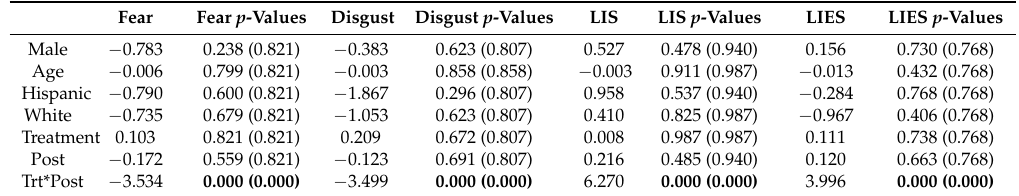
Table 3. Log Odds Ratio Estimates for Cumulative Logit Models Separately Fit for Fear toward Spiders, Disgust toward Spiders, Likelihood of Incorporating Information about Spiders into their Science Classroom (LIS) and Likelihood of Incorporating Information about the Ecological Services of Spiders into their Science Classroom (LIES) with Corresponding Pointwise p -values (Multiplicity Adjusted p